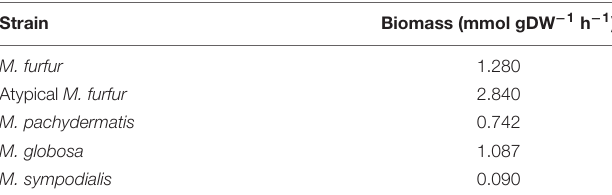
TABLE 4 | Predicted biomass flux with the flux balance